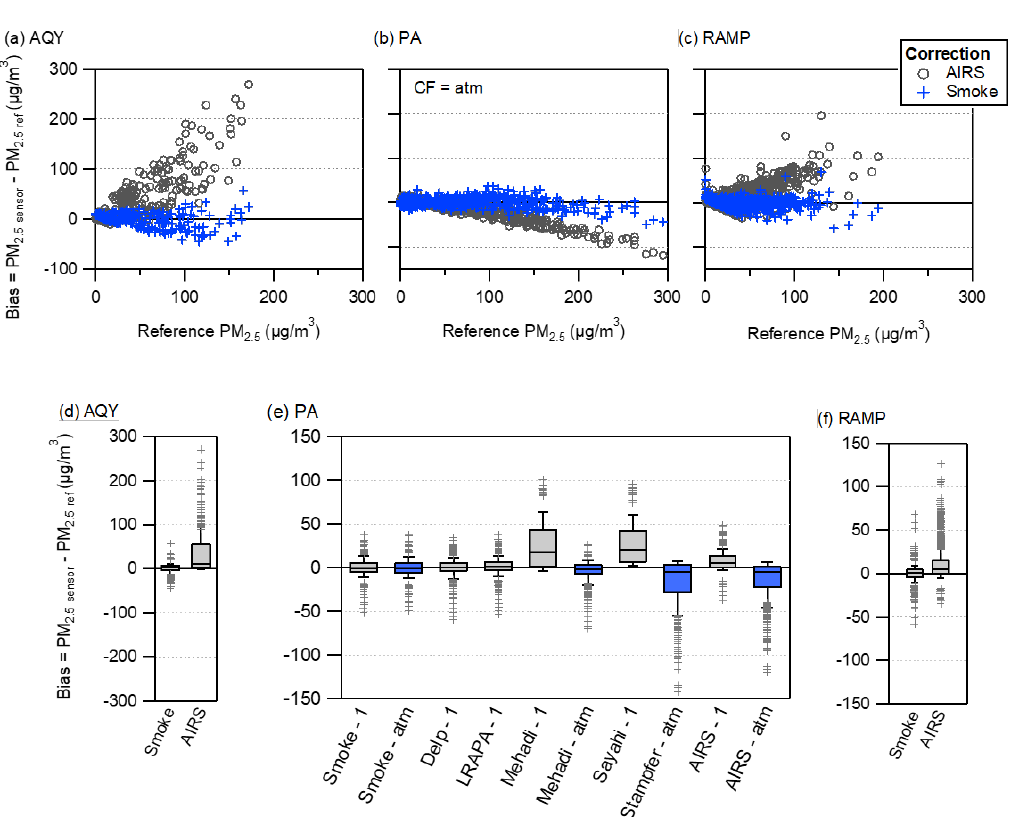
Figure 3. Bias for the AIRS ambient and smoke corrected sensor measurements for the ( a ) AQY ( b ) PA and ( c ) RAMP. Box plots of the hourly bias values for di ff erent correction equations for the ( d ) AQY ( e ) PA and ( f ) RAMP. ‘Smoke’ correction is from all smoke impacted sites, ‘AIRS’ correction is for ambient in NC, PA corrections from the literature are from smoke impacted Delp and Singer [23], Lane Regional Air Programs Association (LRAPA) [31], Mehadi et al. [7], Sayahi et al. [8], and Stampfer et al. [32]. ‘-1’ and ‘-atm’ refer to the data source the correction was applied to and was based o ff current understanding of the data source used to generate each correction.